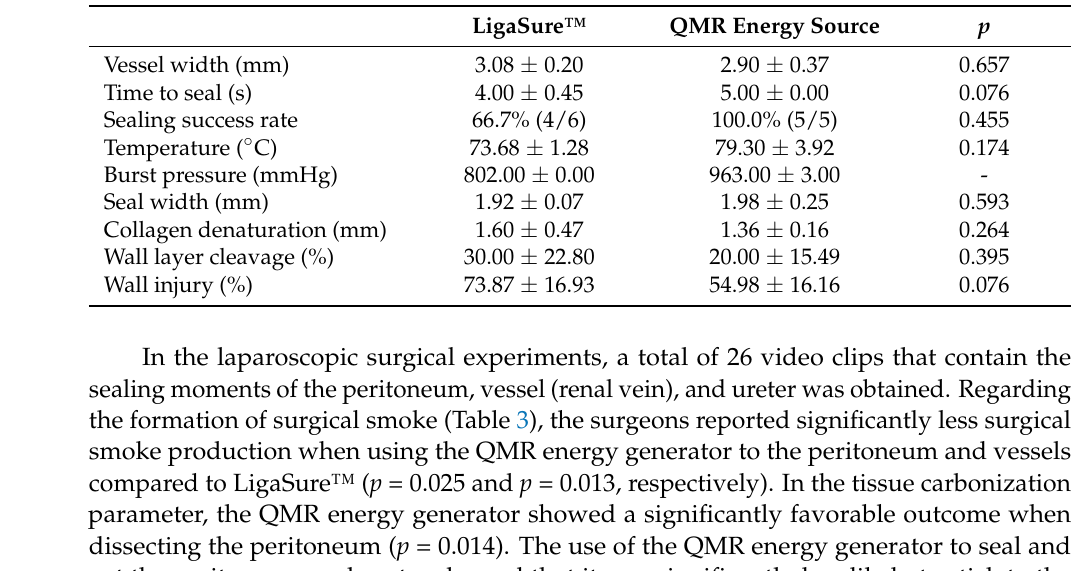
Table 3. Evaluated Parameters in the surgeon’s experience of Laparoscopic nephrectomy. Peritoneum Vessel Ureter LigaSure™ QMR ( n = ( n = 42)